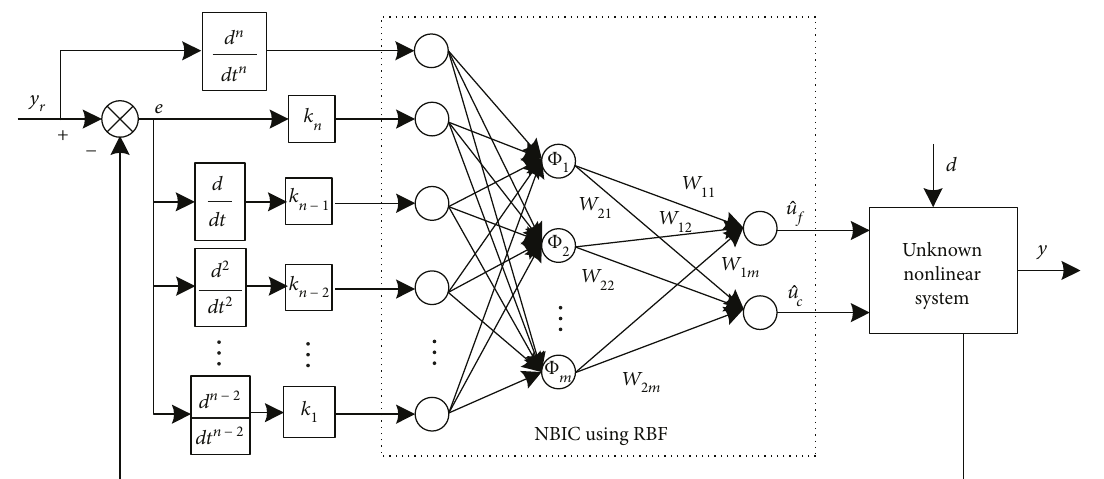
Figure 2: The structure of neural network-based direct inverse controller using